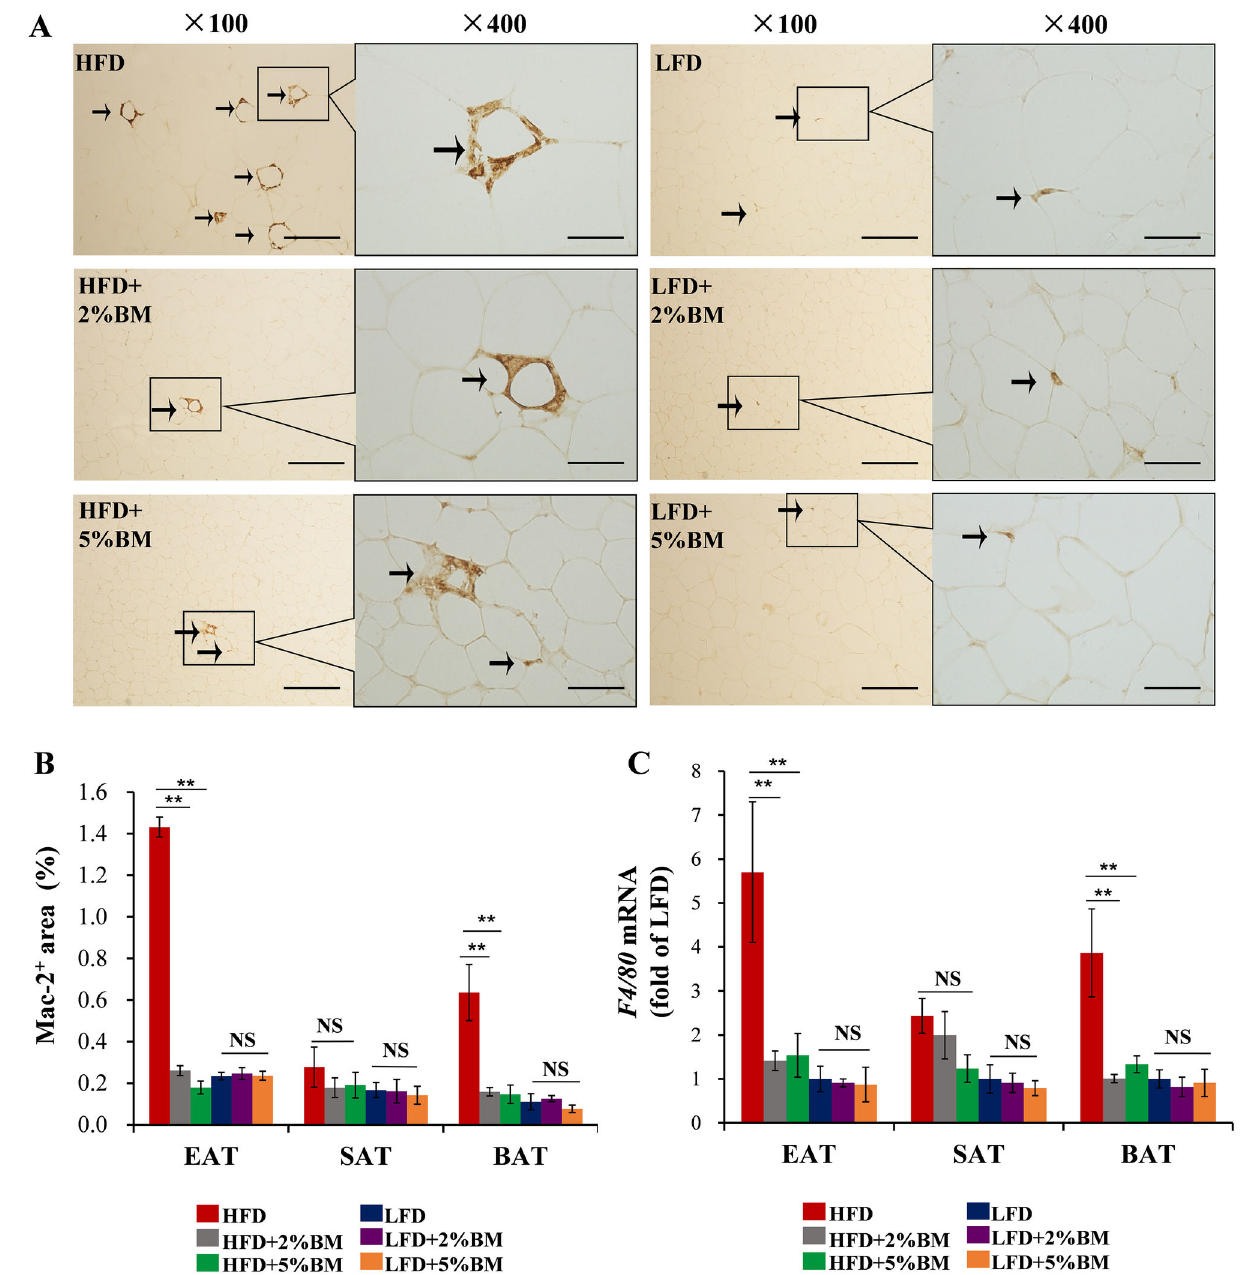
Figure 3. Bitter melon inhibited the recruitments of inflammatory macrophages into EAT and BAT in mice. (A) Mac-2 immunostaining in EAT of mice; arrows indicate Mac-2 + macrophages; scale bars in (A), 100μm in length in low power views (×100) and 25μm in length in high power views (×400). (B) Quantification of Mac-2 + macrophage area in EAT, SAT and BAT of mice. (C) Real-time PCR quantitative mRNA expression of macrophage marker gene F4/80 in EAT, SAT and BAT of mice. Statistical difference between groups is shown using a nonparametric Mann-Whitney test. n=8 per group. * P <0.05, ** P <0.01. All data in (B)- (C) are means ± SEM. doi: 10.1371/journal.pone.0084075.g003 6A and 6B), but not in SAT and BAT (Figure 6B). BM-contained of the mice with HFD, while there was no significantly diets suppressed the mast cell number enhancements in EAT difference among 3 groups with LFD (Figure 6A and 6B).